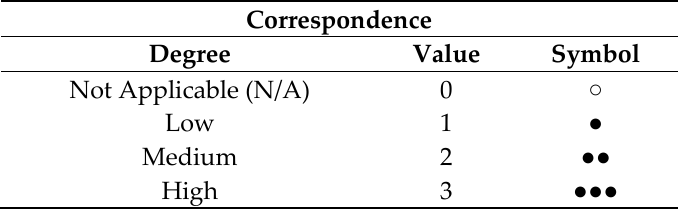
Table 1. Evaluation system used in the multi-criteria decision analysis (MCDA)